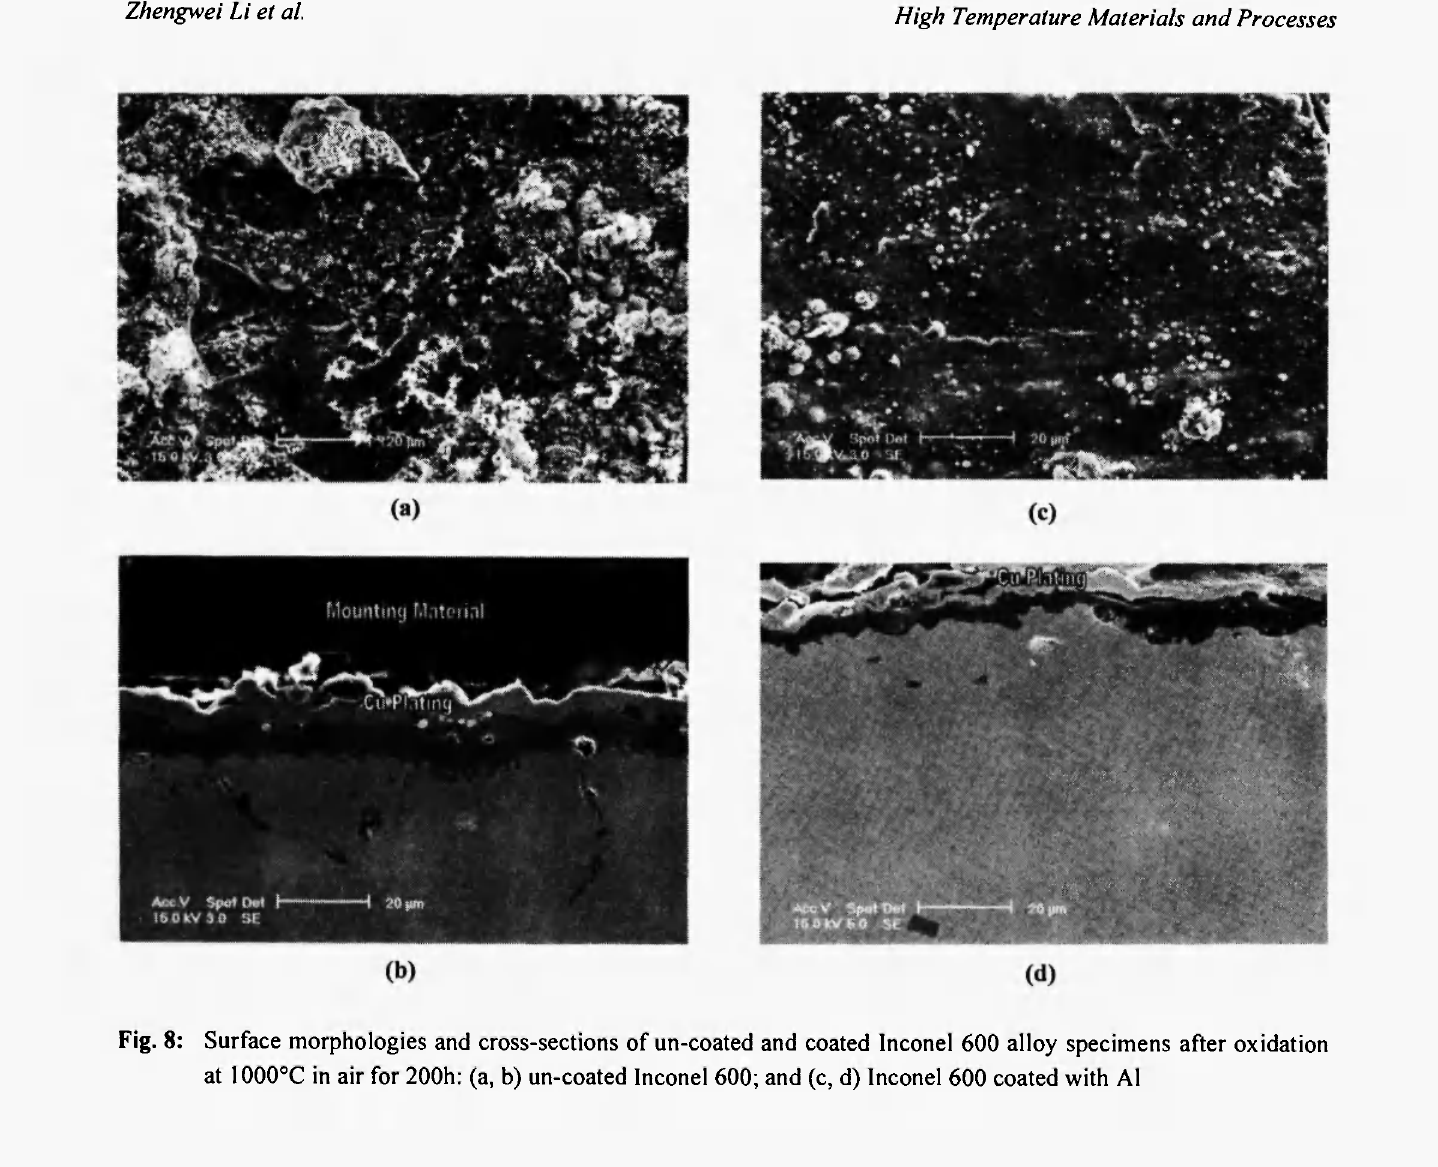
Fig. 8: Surface morphologies and cross-sections of un-coated and coated Inconel 600 alloy specimens after oxidation at 1000°C in air for 200h: (a, b) un-coated Inconel 600; and (c, d) Inconel 600 coated with